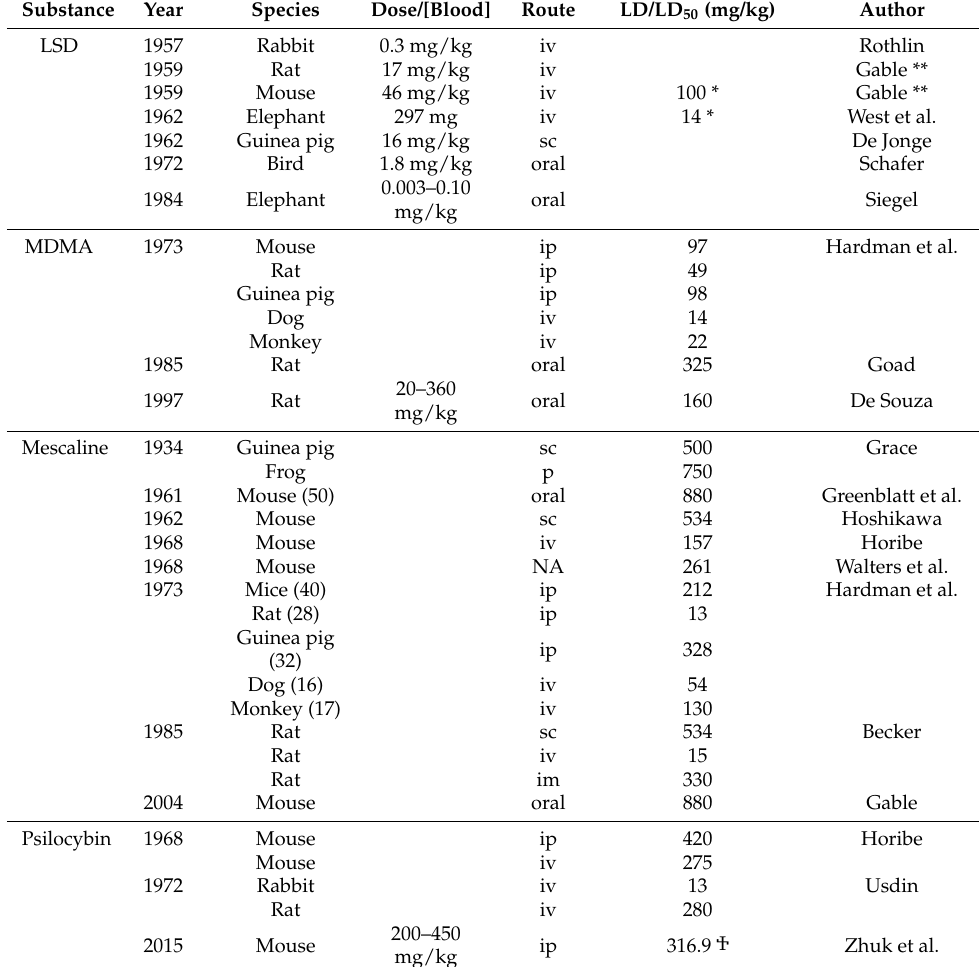
Table 1. Description of experiments related to high/lethal doses of psychedelics in